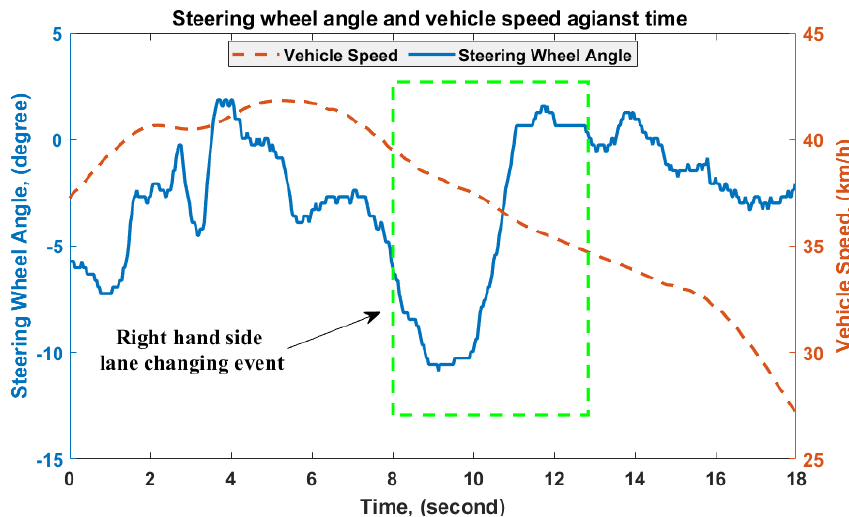
Figure 6: Steering wheel angle and vehicle speed datasets from clip #13